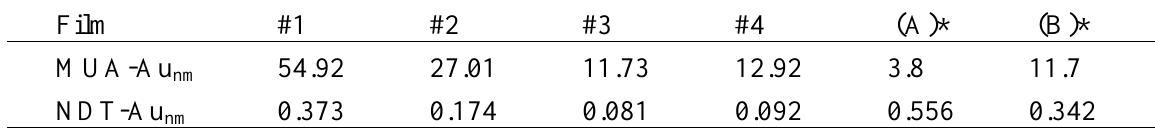
Table 2. Initial resistance values of the nanostructured thin films on different IMEs (M Ω